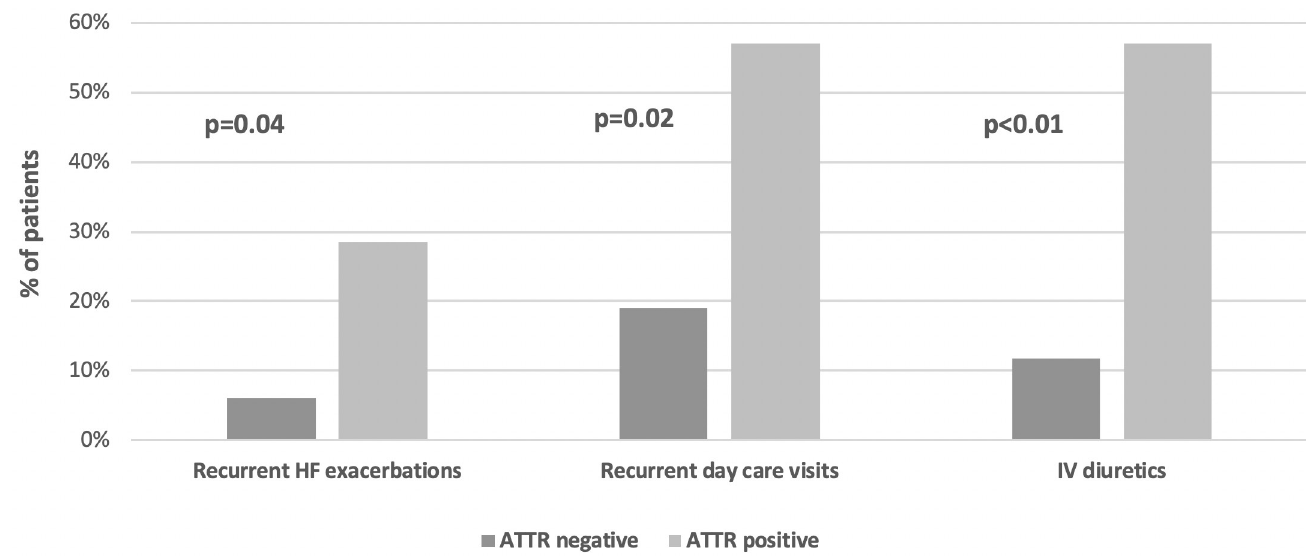
Fig 3. Comparison of clinical course between patents with and without ATTR-CA according to heart failure exacerbation events. https://doi.org/10.1371/journal.pone.0254104.g003 [18,19]. We believe that using both the CZT camera and the addition of SPECT imaging is suf- ficient to establish the diagnosis of ATTR-CA in the absence of monoclonal gammopathy.